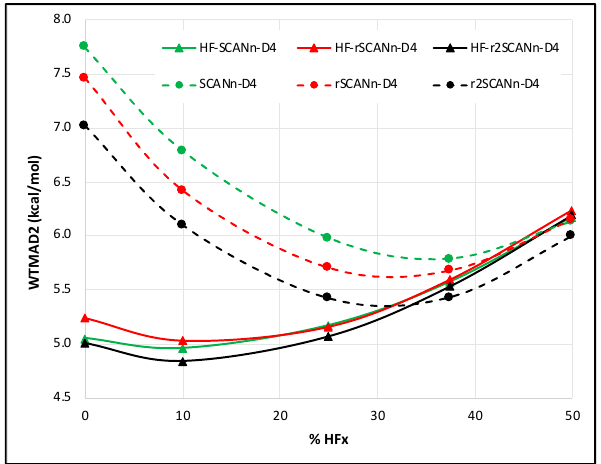
Figure 3. WTMAD2 (kcal/mol) trend with respect to the percentage of HF-like exchange (n) for self-consistent and HF-DFT-D4 forms of SCAN, rSCAN, and r 2 SCAN. The solid lines represent the HF-DFTs, and the dashed lines are for the corresponding self-consistent series.